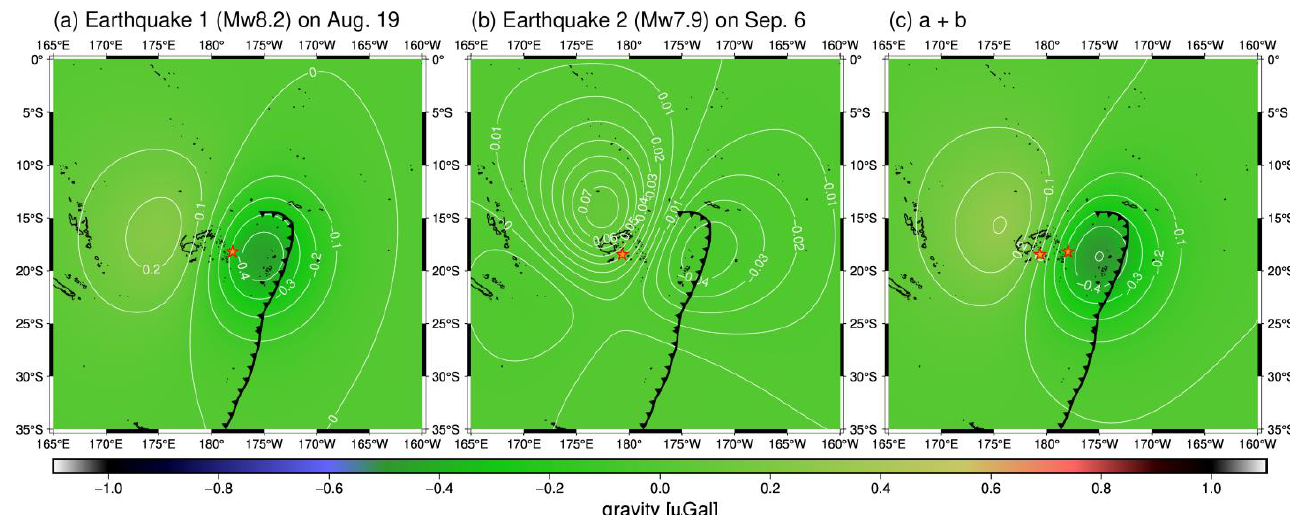
Figure 1. Calculation of the coseismic gravity changes caused by the two 2018 Fiji deep-focus earth- quakes based on USGS CMT solutions. The trench is shown by using the mark of the cold front. ( a ) The result of the 19 August 2018, earthquake. ( b ) The result of the 6 September 2018, earthquake. ( c ) The sum of ( a , b ). The contour intervals of ( a – c ) are 0.1 μGal, 0.01 μGal, and 0.1 μGal, respectively. Stars indicate the locations of the CMT solutions. The color scale is the same as that used in Figure 2 for comparison.